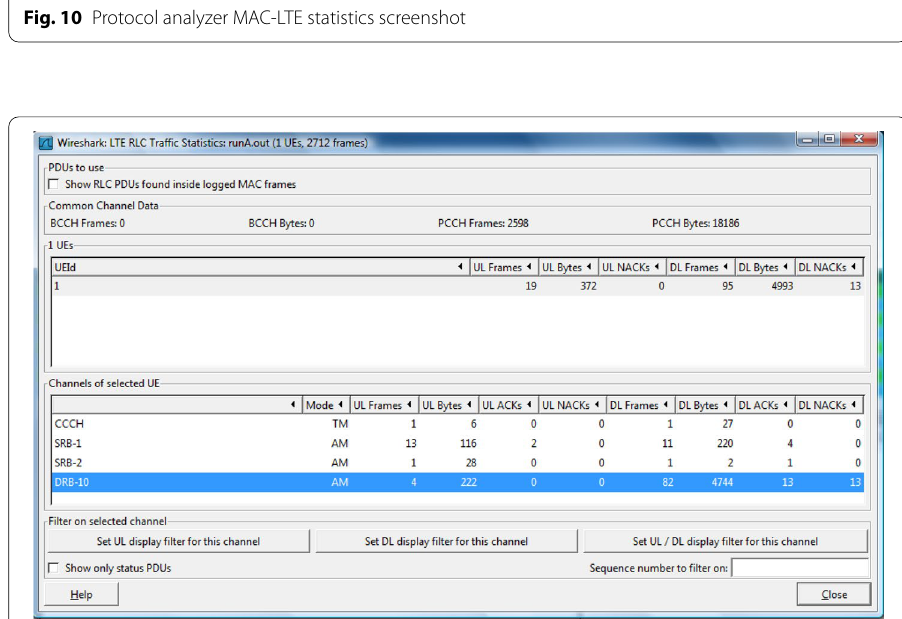
Fig. 11 Protocol analyzer RLC-LTE statistics